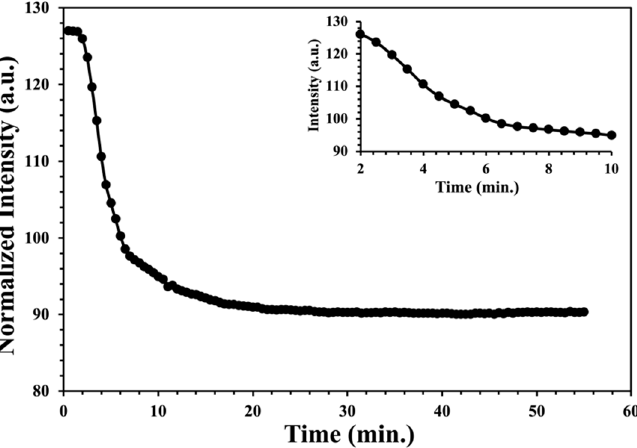
Figure 5. The raw reflected intensity with time from an XploSafe PS test strip during exposure to a hydrogen peroxide gas at a concentration of 28 ppm. The insert shows a blowup of rapid decrease in intensity between 2 and 10 min.